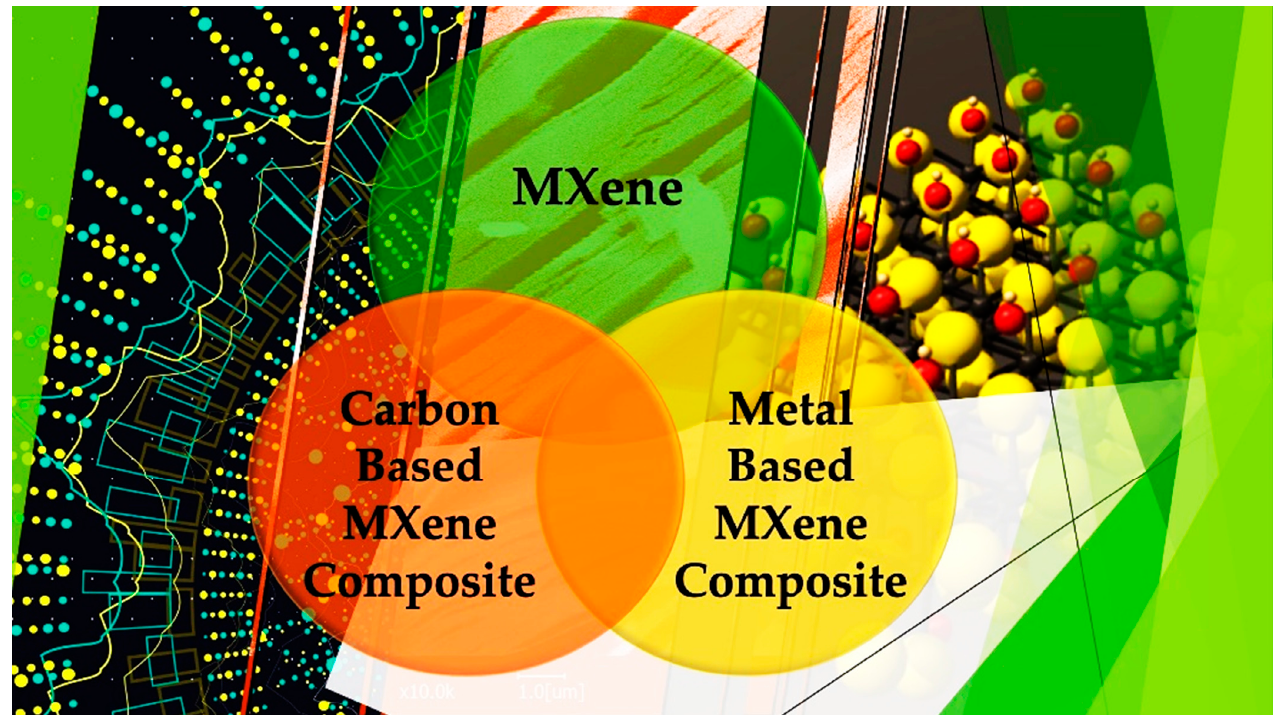
Figure 9. General classification of MXene-based composites. [143].